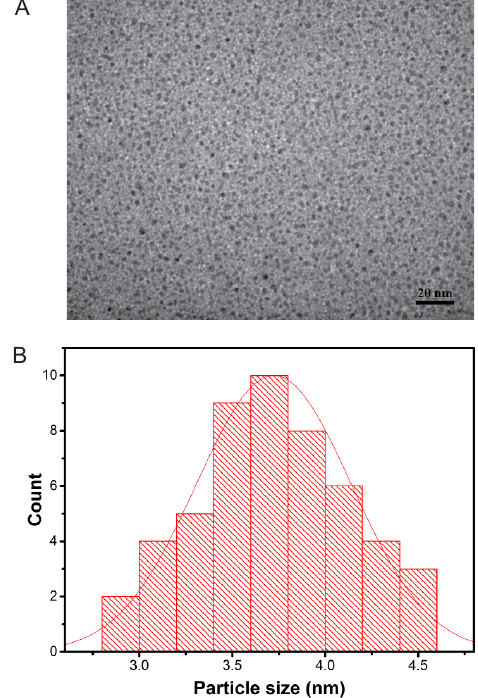
Fig. 4A. TEM image of Cu O NCBs/CS NPs composites; 2 B. Particle size distribution of Cu O NCBs/CS NPs 2 composites, respectively.